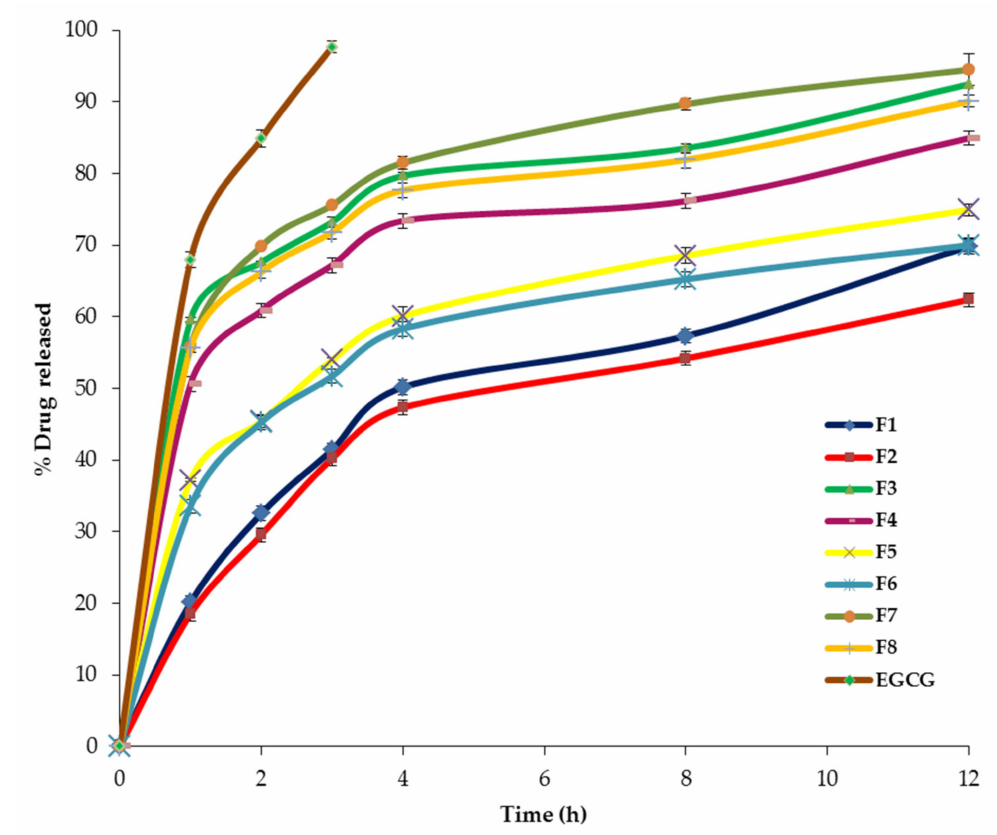
Figure 6. The in vitro release profile of EGCG-loaded spanlastics and EGCG dispersion for 12 h. Abbreviation: EGCG, epigallocatechin